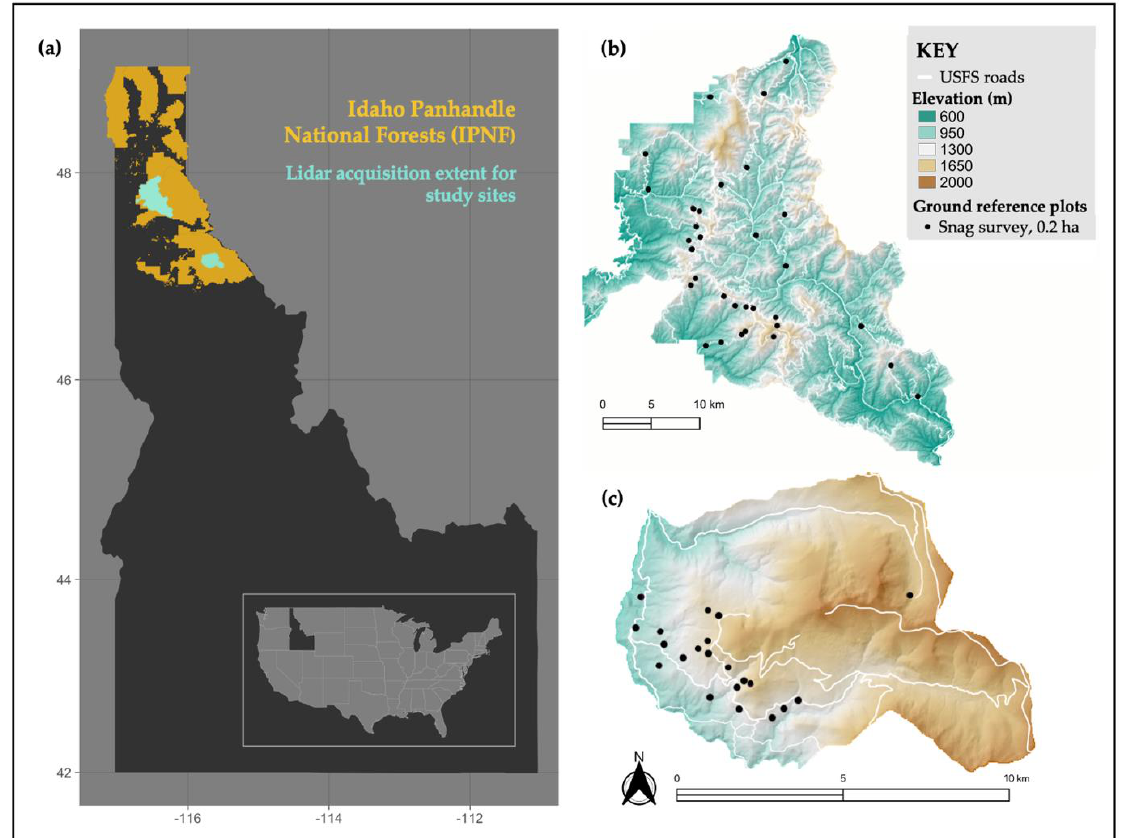
Figure 1. Map of the study area. ( a ) Study area within Idaho Panhandle National Forests (IPNF) in northern Idaho, United States of America. There were two lidar acquisitions in the IPNF where all ground reference survey data were collected: within the ( b ) Coeur d’Alene River (CdA) and ( c ) Saint Joe (StJ) Ranger Districts. Please note the different scales for each site. Across the two sites there were a total of 53 25 m fixed-radius ground reference plots (0.2 ha; black circles) where all 198 snags included in this study were surveyed. This figure was adapted from [6].